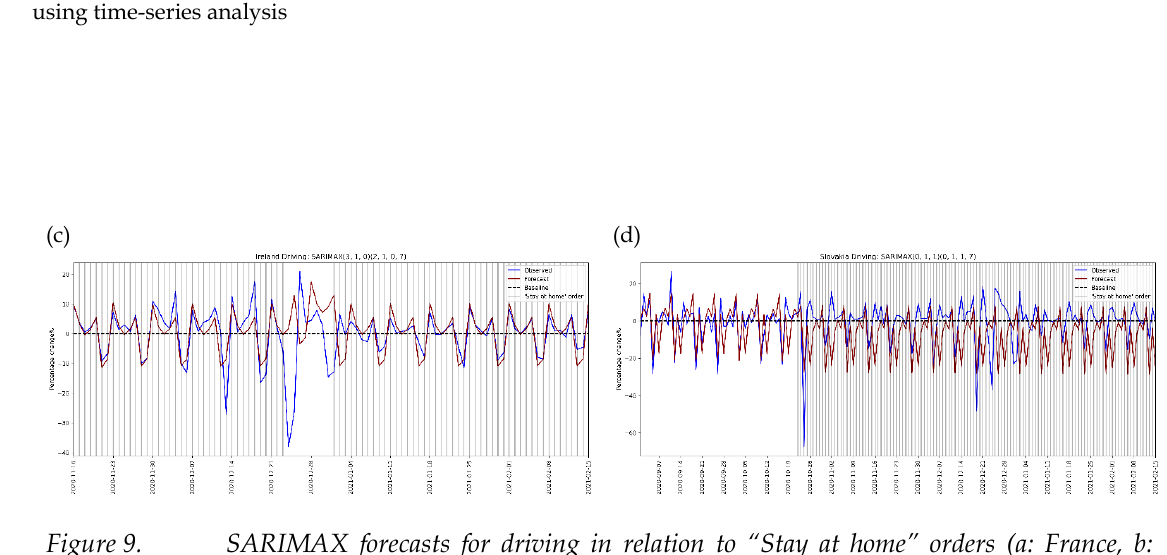
Figure 9. SARIMAX forecasts for driving in relation to “Stay at home” orders (a: France, b: Greece, c: Ireland, d: Slovakia)